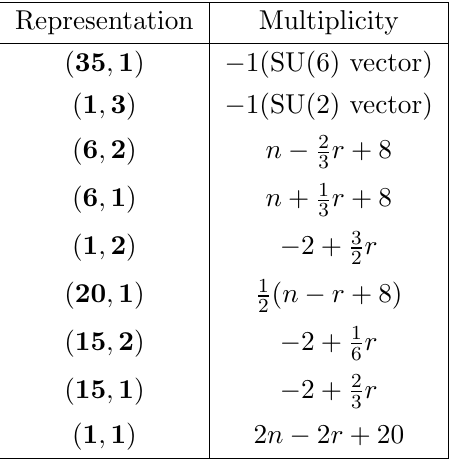
Table 18 . The spectrum for the con(cid:12)guration